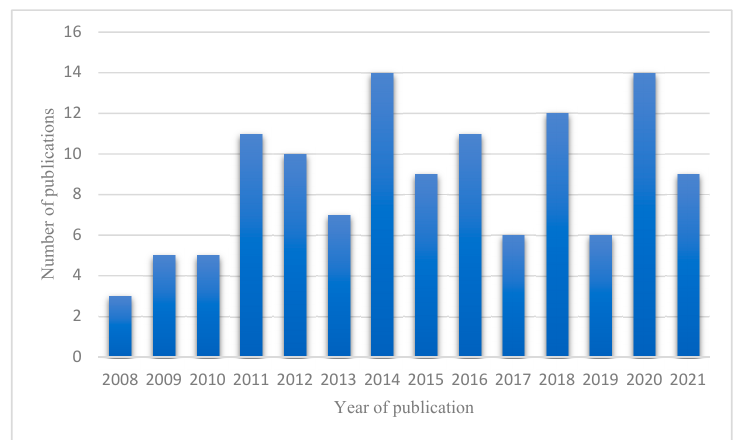
Figure 5. Distribution of total selected publications per year.